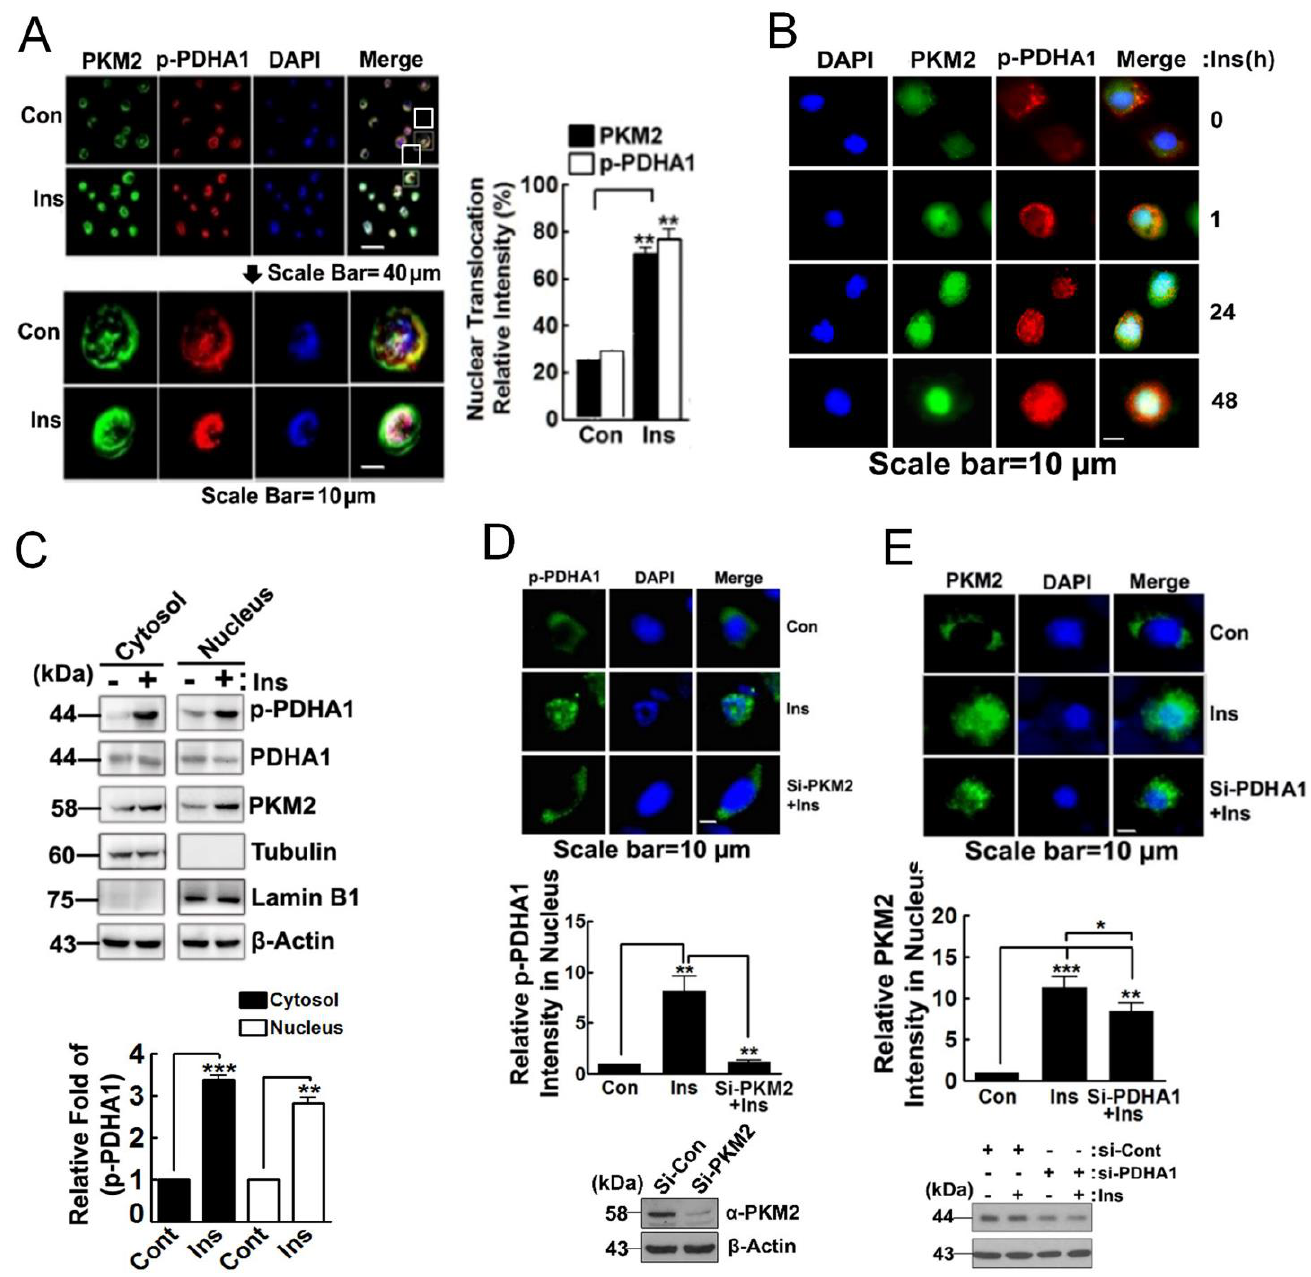
Figure 2. PKM2 delivers phosphorylated-Ser293 PDHA1 (p − PDHA1) to the nucleus. ( A , B ) HepG2 cells were stimulated with 100 nM insulin for 48 h ( A ) or 1, 24, and 48 h ( B ), p-PDHA1 and PKM2 changes were identified with immunohistochemistry. ( C ) HepG2 cells were treated with 100 nM insulin for 48 h, and cytosolic and nuclear fractions were separated, and then p-PDHA1 and PKM2 were determined by Western blotting. ( D ) si-PKM2 was transfected into HepG2 cells and insulin (100 nM for 48 h) was added to the cells, and p-PDHA1 levels were visualized with immunohistochemistry. Knockdown PKM2 levels were measured by Western blotting. ( E ) si-PDHA1 was transfected, then PKM2 was visualized with immunohistochemistry followed by insulin activation (100 nM for 48 h). PDHA1 silencing level was confirmed by immunoblotting. Statistic data were showed as * p < 0.05, ** p ˂ 0.01; *** p ˂ 0.001 and scale bar was 10 µm.